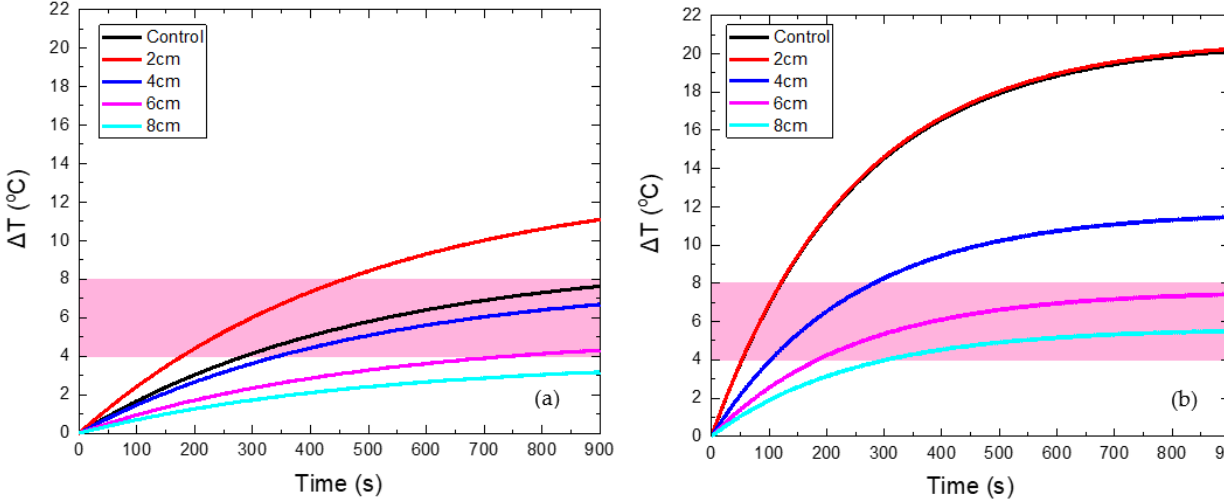
Figure 4. Temperature increase with time in HTP ( a ) and CTP ( b ) samples for non-moving coil, denoted as control case (black curve), and for motion under different maximum displacements (colored curves).